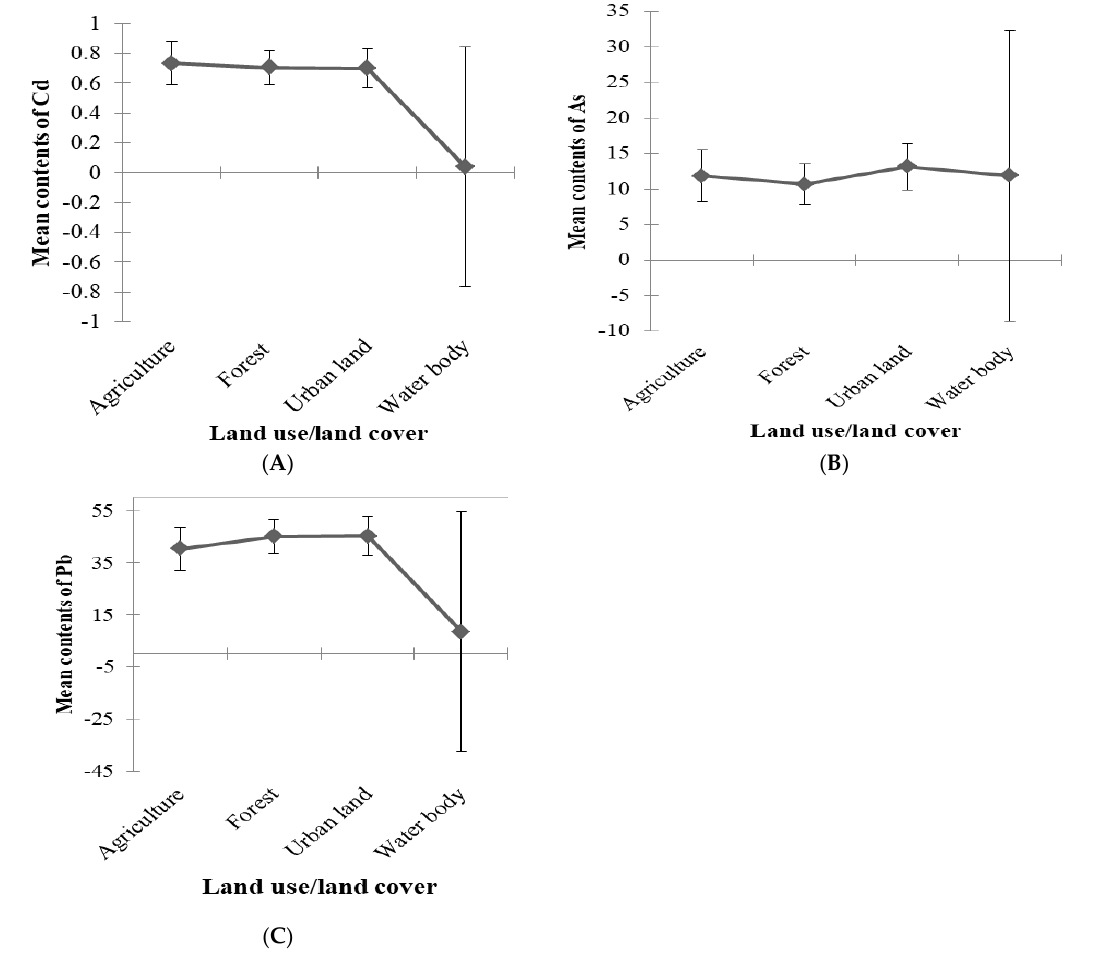
Figure 5. Impact of land use on ( A ) Cd, ( B ) As, and ( C ) Pb contents. Likewise, the selected heavy metals content was variable across landforms, where Cd had maximum values (0.89 mg/g) in the medium-gradient mountain (SM) landform, followed by the high-gradient mountain (TM), high-gradient hill (TH), medium gradient hill (SH), plain (LP) and shoreline (WR) landforms (Figure 6A). The As content decreased in the order of medium gradient hill (SH), high-gradient mountains (TM), plain (LP), medium-gradient mountain (SM), and high-gradient hill (TH) landforms (Figure 6B). The Pb content was higher (77.35 mg/g) in the medium-gradient mountain (SM) landform, followed by shoreline (WR), plain (LP), medium gradient hill (SH), medium-gradient mountain (SM), and high-gradient hill (TH) landforms (Figure 6C). Landform variability had a significant impact on the spatial distribution of Pb at p < 0.01.